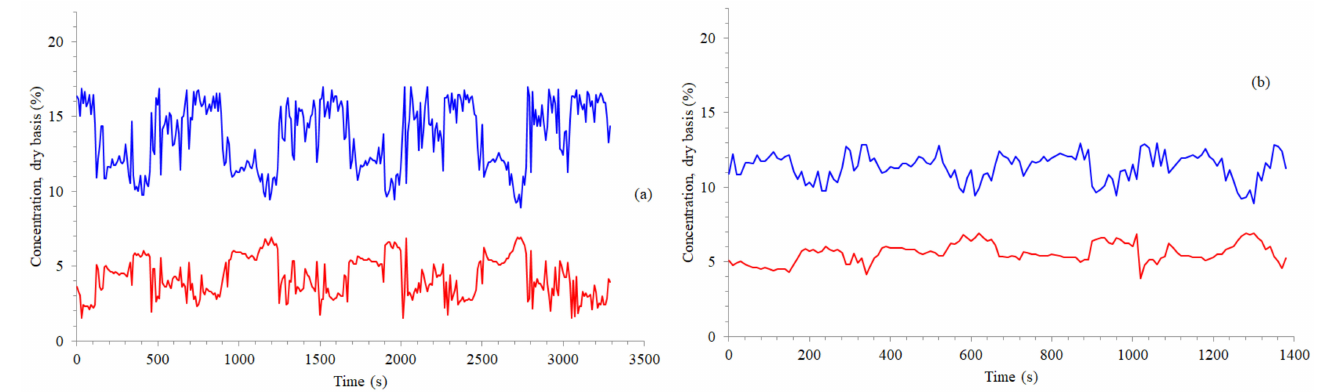
Figure 6. The O 2 and CO 2 concentrations as functions of time for Truck #4: for [O 2 ] D < 17% ( a ), for [O 2 ] D < 13% ( b ).